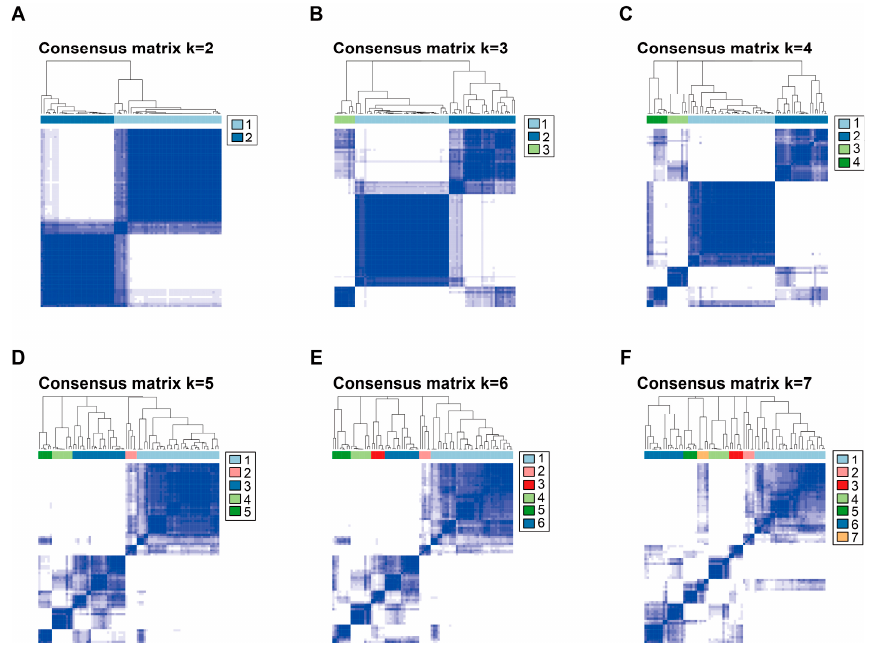
Figure 4. Consensus clustering matrix of TCGA-ACC samples. ( A ) Consensus clustering matrix of TCGA-ACC samples for k = 2. ( B ) Consensus clustering matrix of TCGA-ACC samples for k = 3. ( C ) Consensus clustering matrix of TCGA-ACC samples for k = 4. ( D ) Consensus clustering matrix of TCGA-ACC samples for k = 5. ( E ) Consensus clustering matrix of TCGA-ACC samples for k = 6. ( F ) Consensus clustering matrix of TCGA-ACC samples for k = 7.